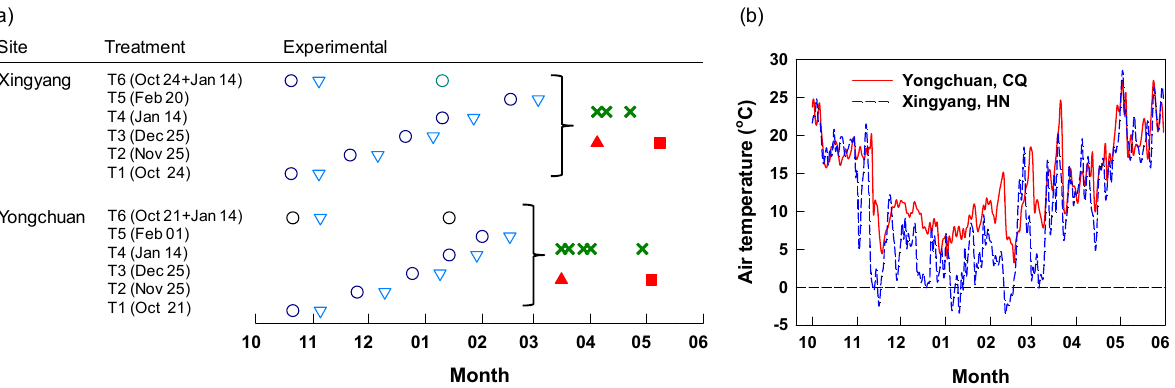
Figure 1. The experimental design ( a ) and daily air temperature ( b ) at Yongchuan and Xingyang. Fertilization ( ○ ); sam ‐ pling of fibrous roots and mature leaves 15 days after application (DAA15, ), on days of the first harvest (DFH, ▲ ) and post ‐ harvest (DPH, ■ ); harvest of the following spring tea ( Χ ).